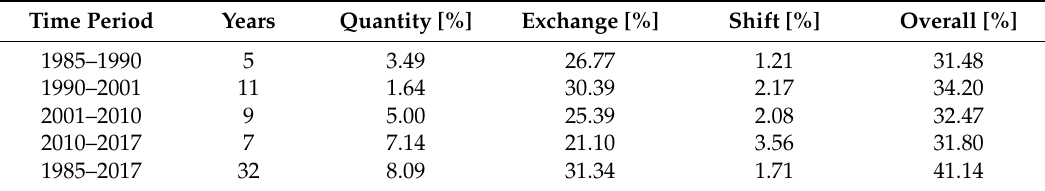
Table 6. Percentages of change types and overall change per time period and the entire study period,